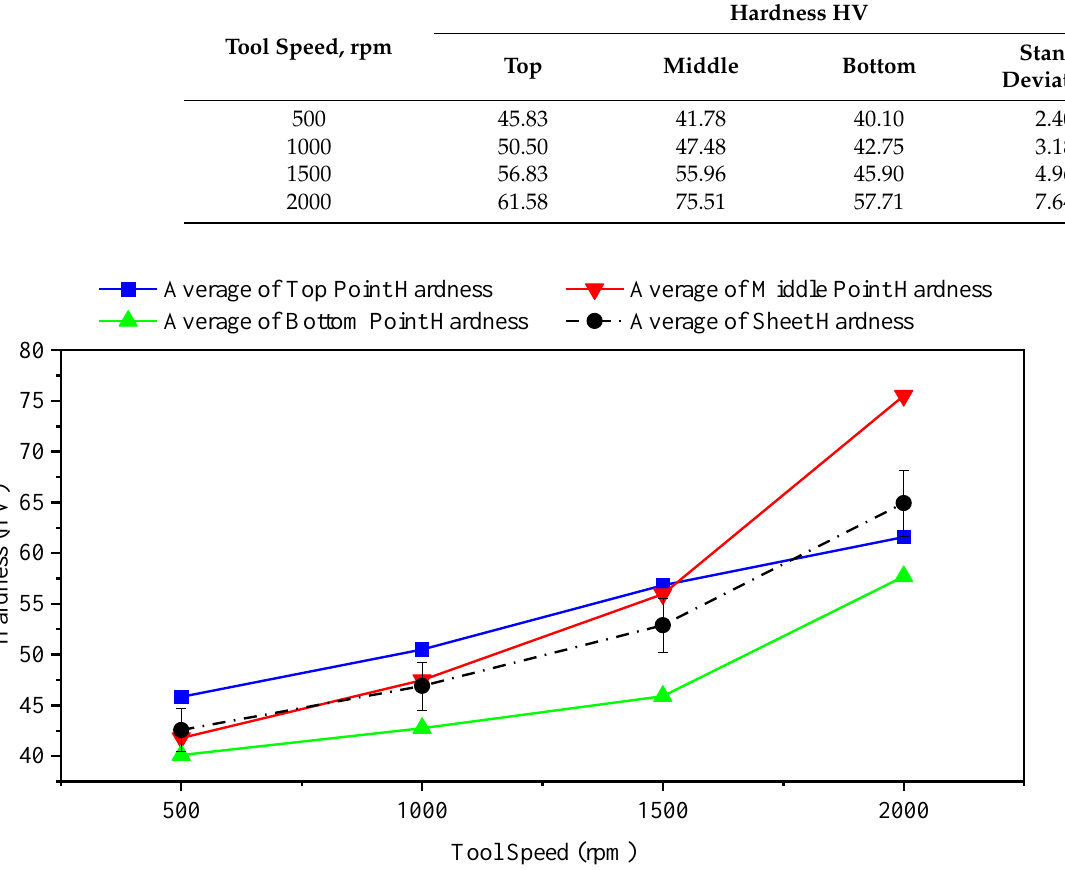
Figure 7. Effect of different tool speeds on hardness of formed sheet (feed rate: 600 mm/min; tool diameter: 10 mm; coolant: oil) .